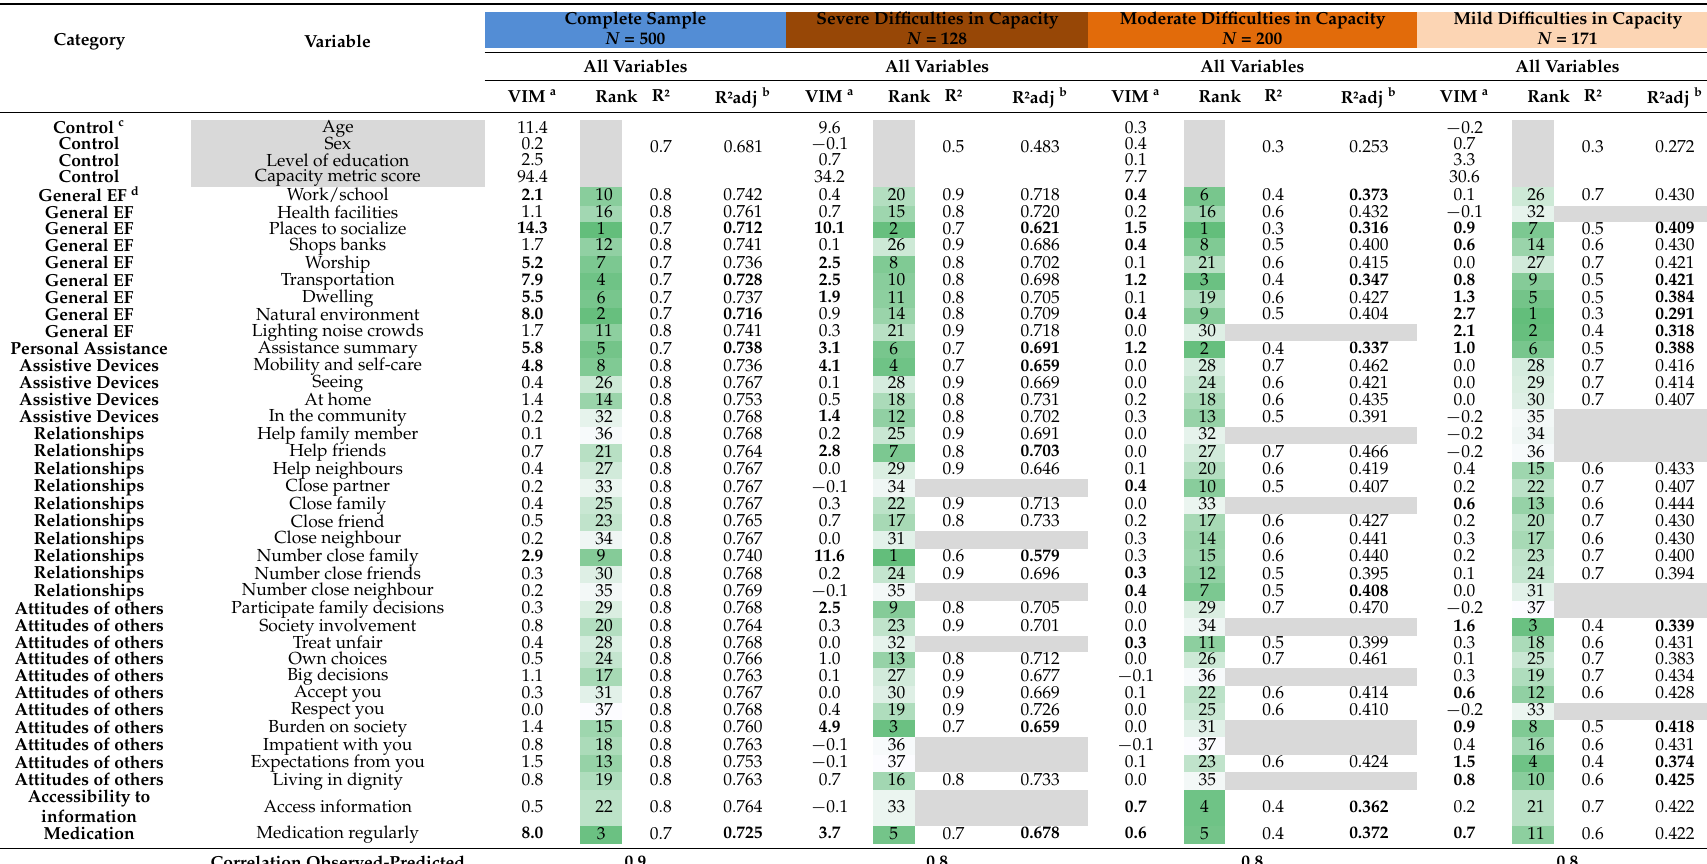
Table 2. Results of the random forest (RF) and multiple linear regression models to determine the most important environmental factors (EFs) with the highest impact on